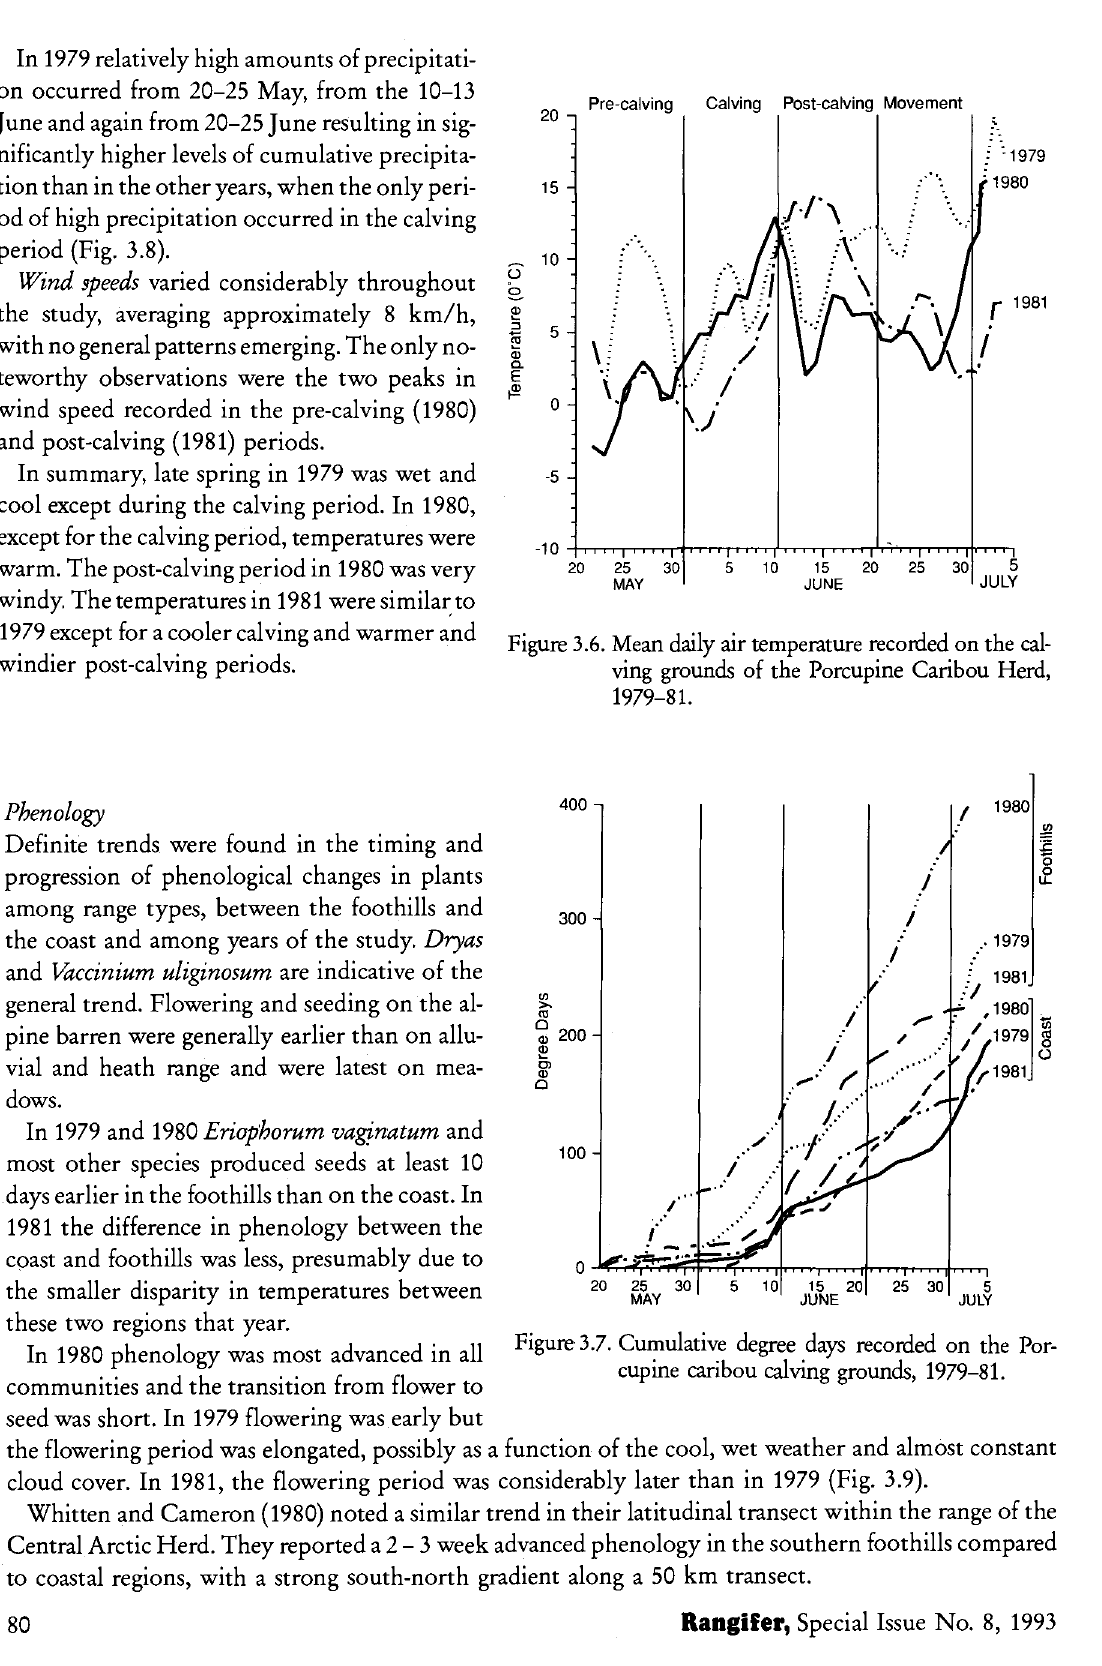
Figure 3.6. Mean daily air temperature recorded on the cal ving grounds of the Porcupine Caribou Herd, 1979-81.